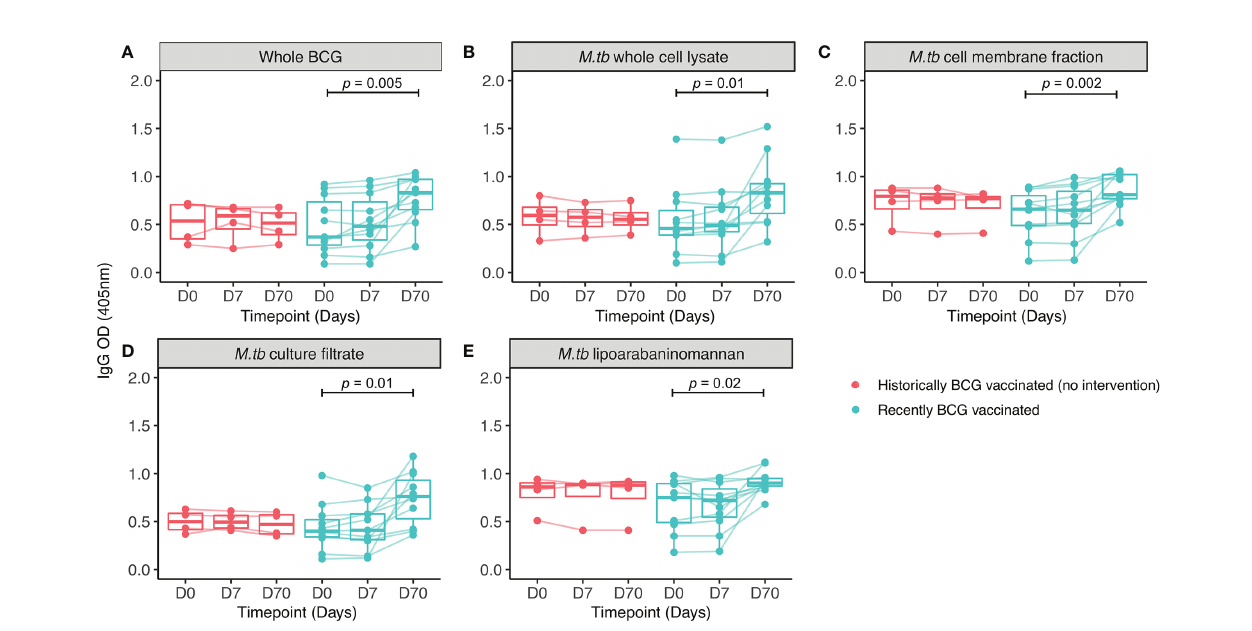
FIGURE 2 | IgG responses to different mycobacterial fractions in serum collected from Nepalese military recruits. Serum samples were taken from Nepalese adults enrolled into human Study 2 (red = historically BCG-vaccinated individuals who received no intervention, cyan = BCG-naïve individuals who received BCG vaccination). IgG responses to whole BCG (A) , M.tb whole cell lysate (B) , M.tb cell membrane fraction (C) , M.tb culture fi ltrate (D) or M.tb lipoarabaninomannan (E) were measured. Points represent the mean of triplicate values, boxes indicate the median value with the interquartile range (IQR) and the upper whisker extends to the largest value no further than 1.5 * IQR from the hinge, the lower whisker extends from the hinge to the smallest value at most 1.5 * IQR from the hinge. Outliers are plotted individually. A repeated measures one-way ANOVA with Dunnett ’ s multiple comparisons test was used to compare between time- points in the BCG vaccinated group.